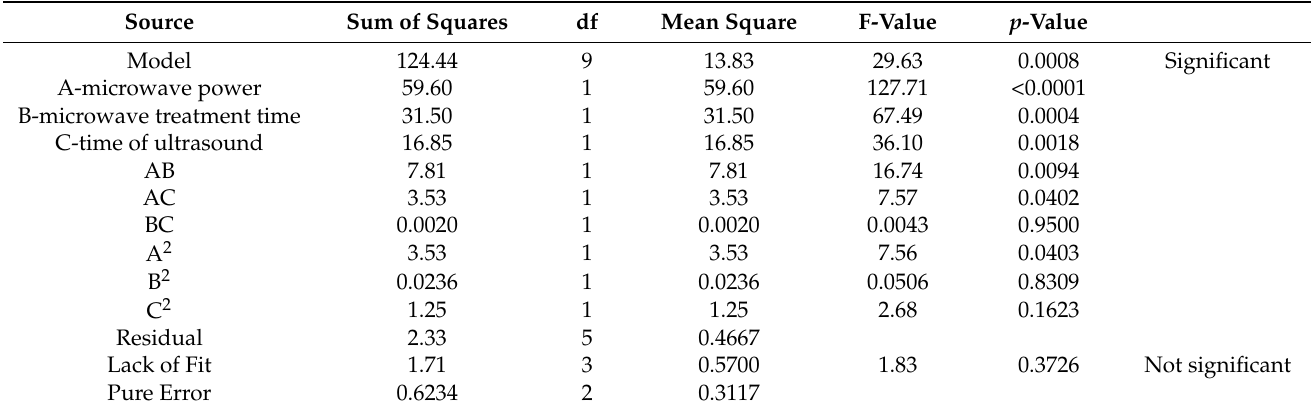
Table 3. Estimated polynomial quadratic model regression coefficients and analysis of variance (ANOVA) for the logarithmic E. coli decrease in orange